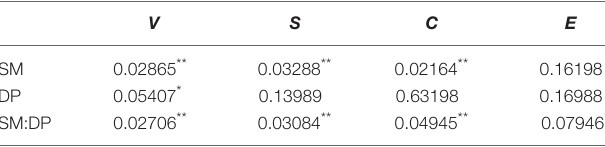
TABLE 3 | Results of ANOVA’s test of p -values for Minkowski functionals as response variables of two factors (SM and DP) with two levels (SMt/SMc and DP1/DP2).